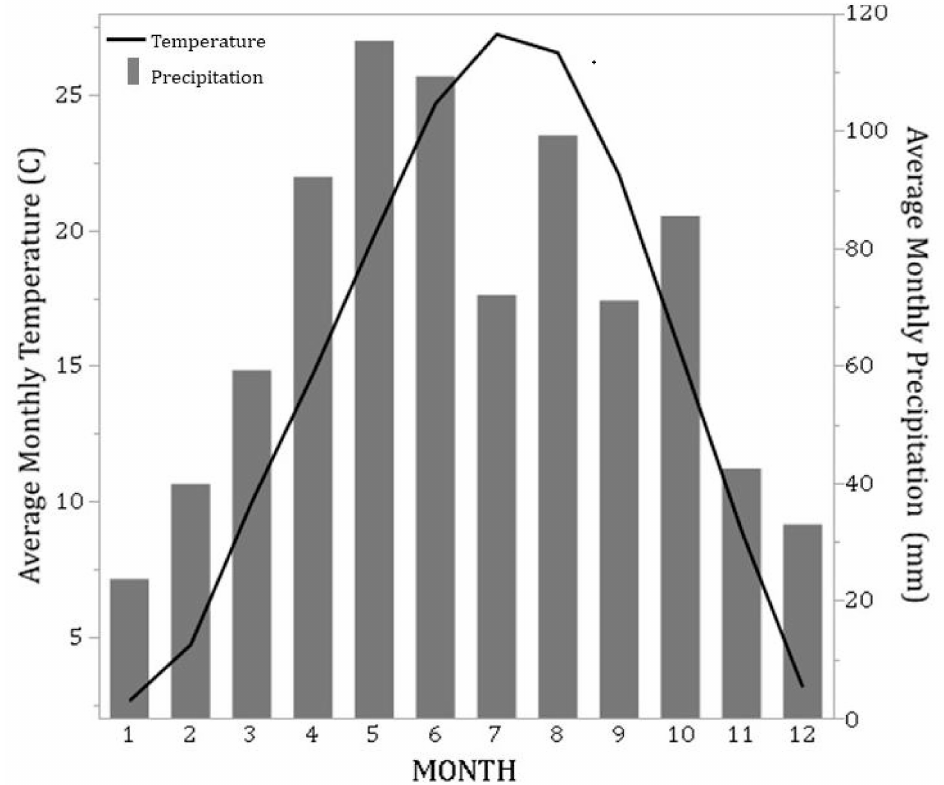
Figure 1. Monthly mean temperature precipitation for the El Reno site of the Oklahoma Mesonet, 1994–2018. Month 1 = January ... Month 12 = December. Data Source: Oklahoma Climate Survey, http: //